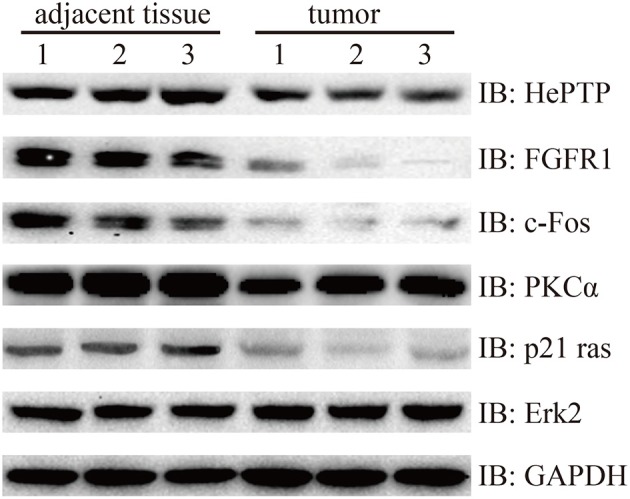
Western blotting detection of MAPK signaling pathway. Lysates from three pairs of bladder cancer and adjacent tissues were subjected to western blotting with antibody to HePTP, FGFR1, c-Fos, PKCα, p21 ras, and Erk2. GAPDH is a reference gene.